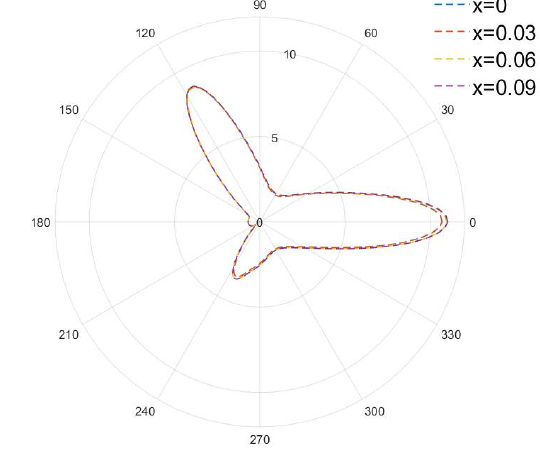
Figure 3. Graph of piezoelectric strain constant ( d 33 ) as a function of doping amount ( x ). It can be determined from the dynamic stress-concentration formula of Equation (22) that the dynamic stress-concentration coefficient is related to the wave number ( the incident elastic wave, the piezoelectric constant ( d 33 ) of the material and the mapping ( ) function ( ). By changing ka , we obtained the stress concentration around the regular n -sided hole on (1 − x )BCTS- x Sm-0.06G with different doping amounts (i.e., different d 33 ), as shown in Figure 4 and Figure 5.